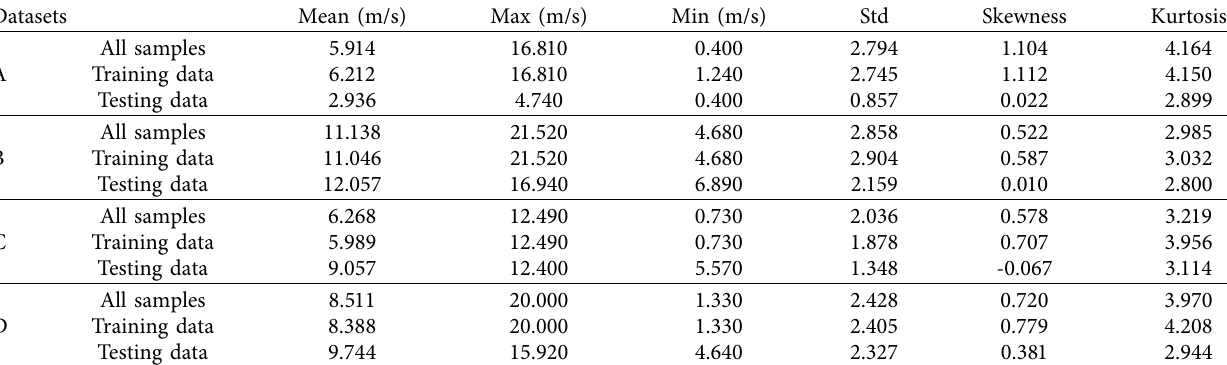
Figure 2: The original wind speed datasets of the experimental data. (a) The original wind speed of dataset A. (b) The original wind speed of dataset B. (c) The original wind speed of dataset C. (d) The original wind speed of dataset D. Table 1: Statistical analysis of each